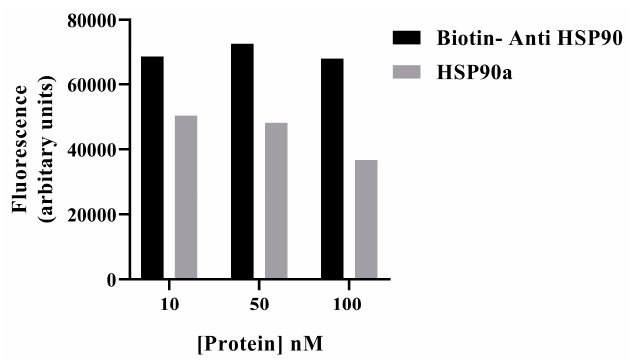
Figure 7. Fluorescence microscopy measurements show a decrease in fluorescence when a compar- ison was made between the attachment of biotinylated antibodies to Sav-QDs and the attachment of HSP90 α to these biotinylated antibodies. Confirming the overall binding of HSP90 α to biotinyl- ated antibodies attached to Sav-QDs. The fluorescence signal is plotted against different concentra- tions of biotin-HSP90 α antibody and HSP90 α .